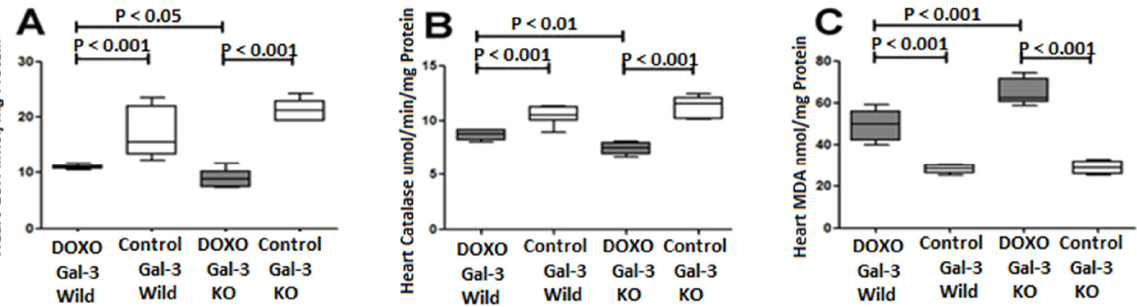
Figure 4. Expression of antioxidants and oxidative stress markers in DOXO-treated mice. Graphs represent cardiac concentrations of ( A ) GSH, ( B ) catalase, and ( C ) MDA at 5 days following DOXO treatment in Gal-3 wild type and Gal-3 KO mice compared to sham-treated controls. p -values < 0.05 were considered statistically significant.